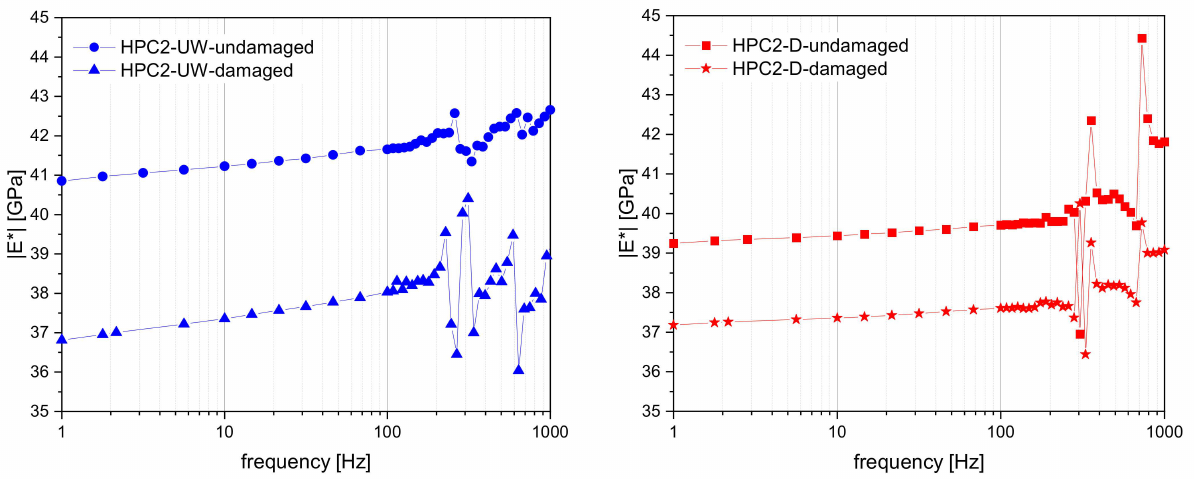
Figure 8. Final temperature ( left ). Temperature increase ( right ).